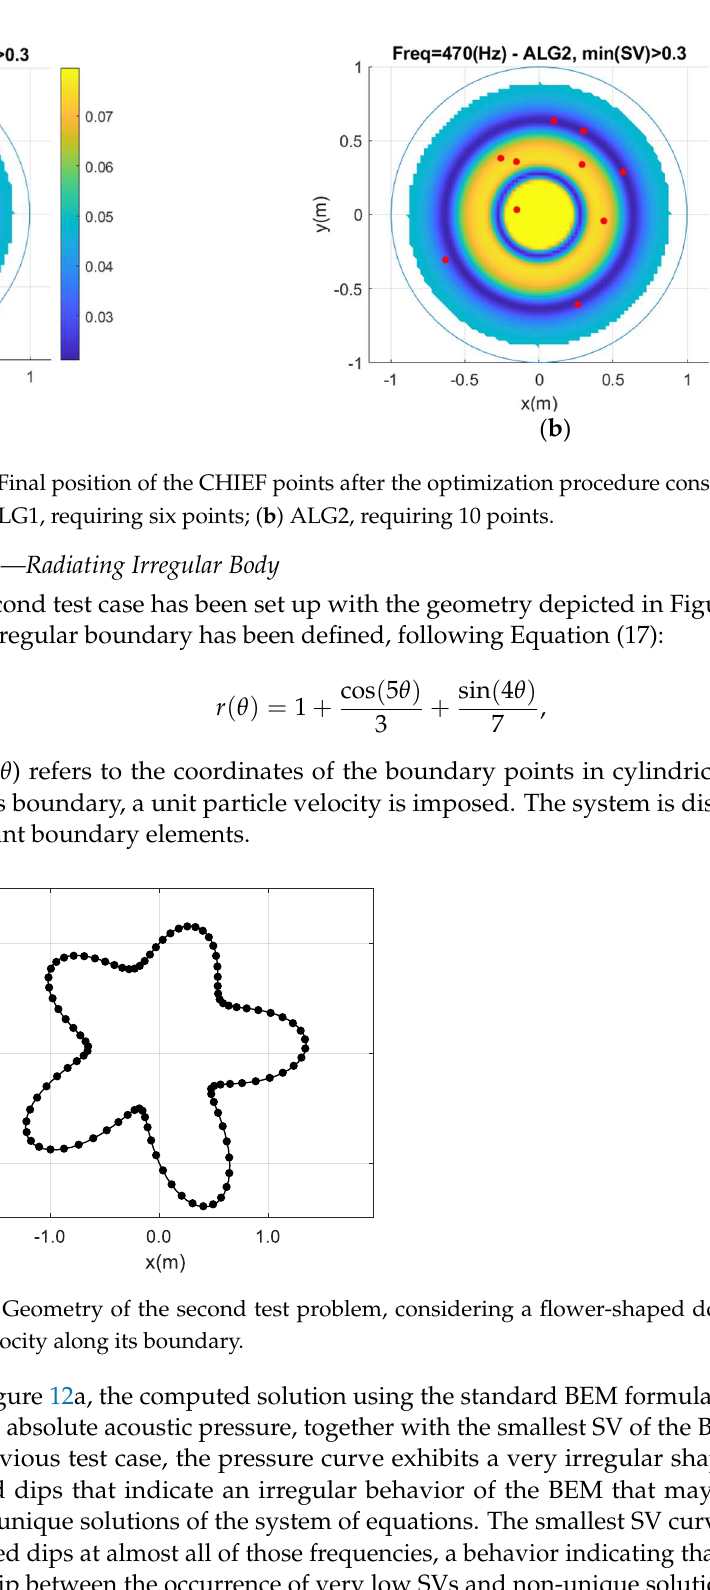
Figure 9. Relative error ( a1 , b1 ) and smallest singular value ( a2 , b2 ) computed for the two algorithms ALG1 ( a1 , a2 ) and ALG2 ( b1 , b2 ), considering different acceptable values for min(SV) of 0.05, 0.1, 0.2 and 0.3. The same color pattern is used for all figures.